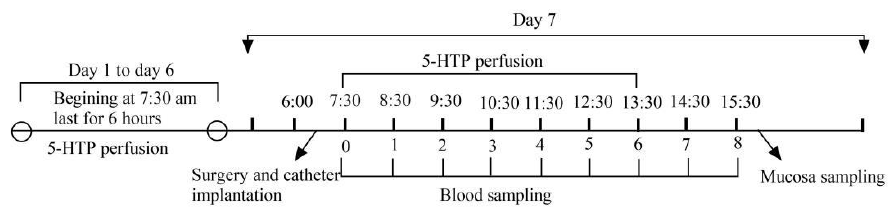
Figure 10. Blood and mucosa sample collection procedure.